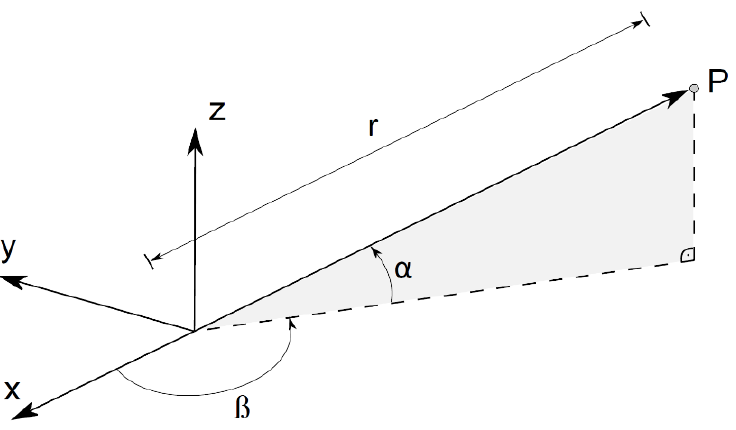
Figure 1. Schematic diagram of the functioning of TLS.